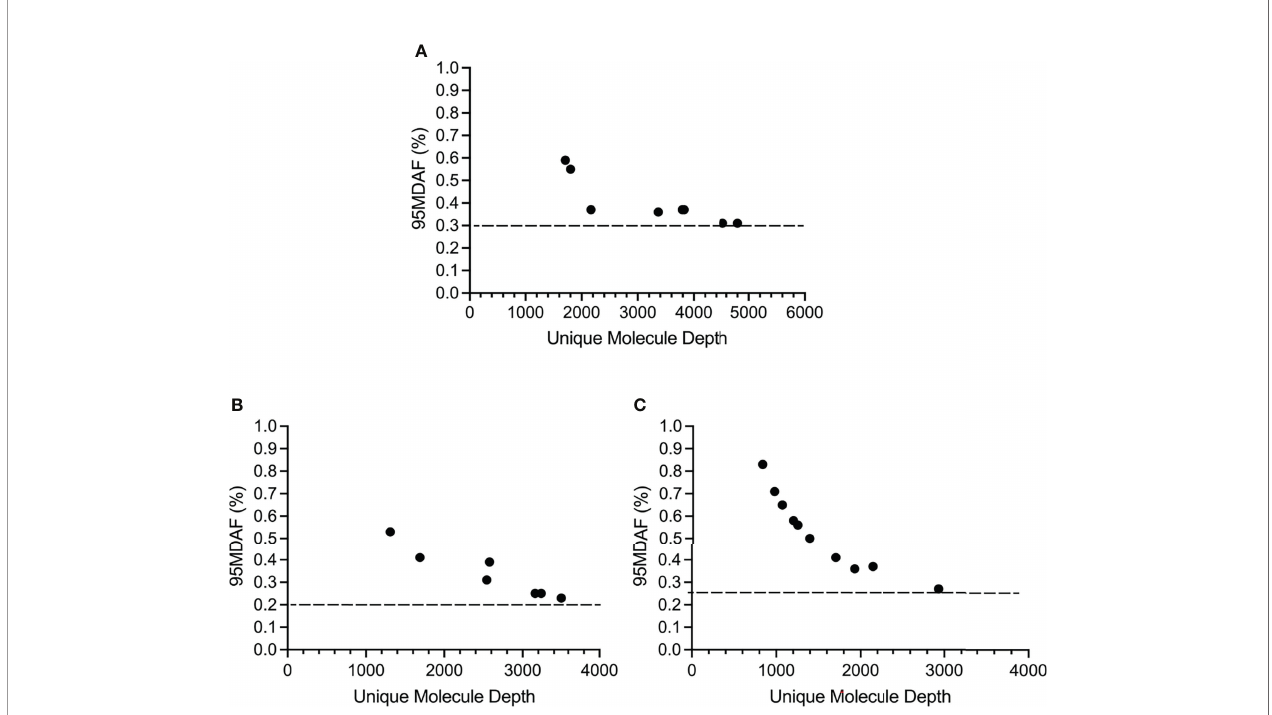
FIGURE 3 | Sensitivity of the custom melanoma ctDNA panel based on BRAF, NRAS or TERT promoter mutations identi fi ed across the melanoma cohort. Each circle corresponds to the 95 minimal detectable allele fraction (95MDAF) values and unique molecule depth (unique fragments covering the speci fi ed region) for a single sample. (A) BRAF V600 mutations. Data derived from samples 1, 3, 4, 9, 10, 13, 16, 19. (B) NRAS G60/Q61 mutations. Data derived from samples 2, 4, 5, 6, 9, 11, 14. (C) TERT 228-250 promoter mutations. Data derived from samples 2, 4, 5, 6, 9, 13, 14, 16, 19,